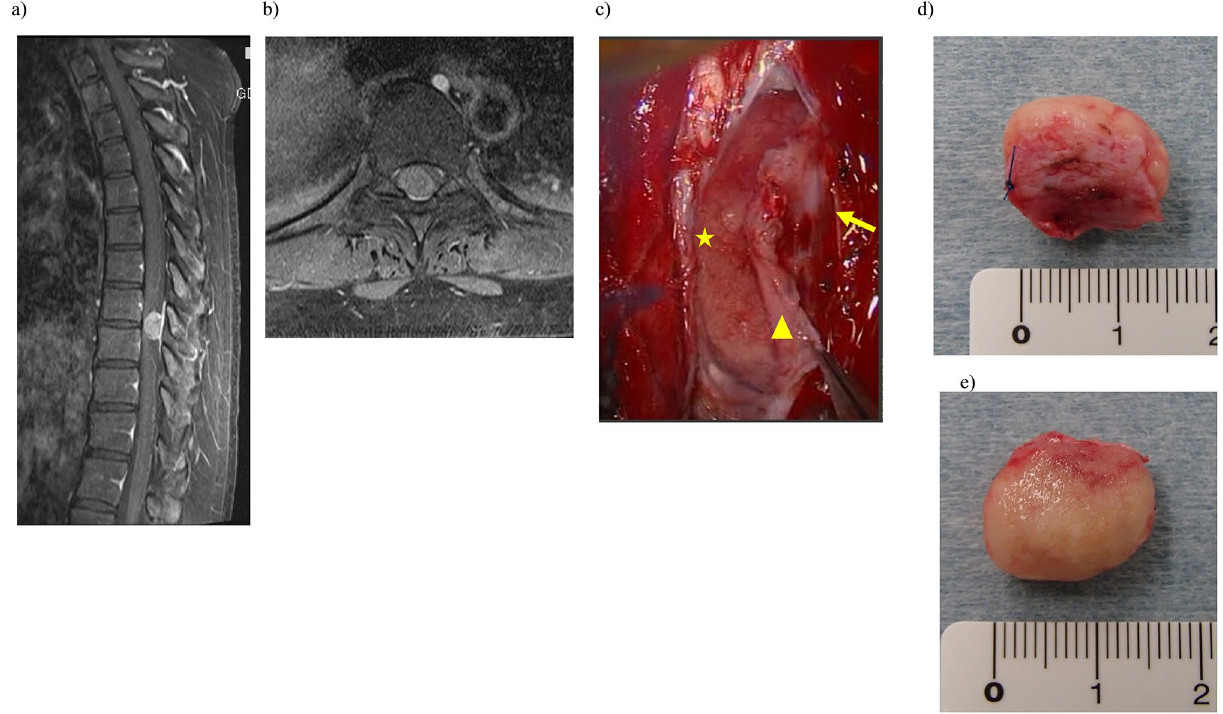
Figure 1. Resection of meningioma at T8/9 level in a 44-year-old woman. T1-weighted magnetic resonance image (MRI) with gadolinium enhancement. ( a ) Sagittal and ( b ) axial views. We measured the maximum tumor length on MRI. ( c ) Resection of meningioma with inner dural layer (triangle), outer dural layer (arrow), and tumor (star). Excised specimen showing ( d ) dural side and ( e ) ventral side. We confirmed attachment of inner dural layer to the